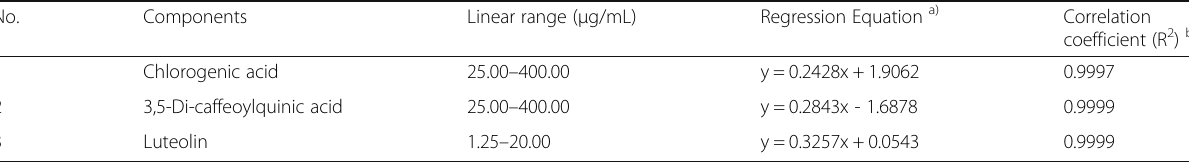
Table 1 Calibration curves of three analytes using HPLC-DAD No.